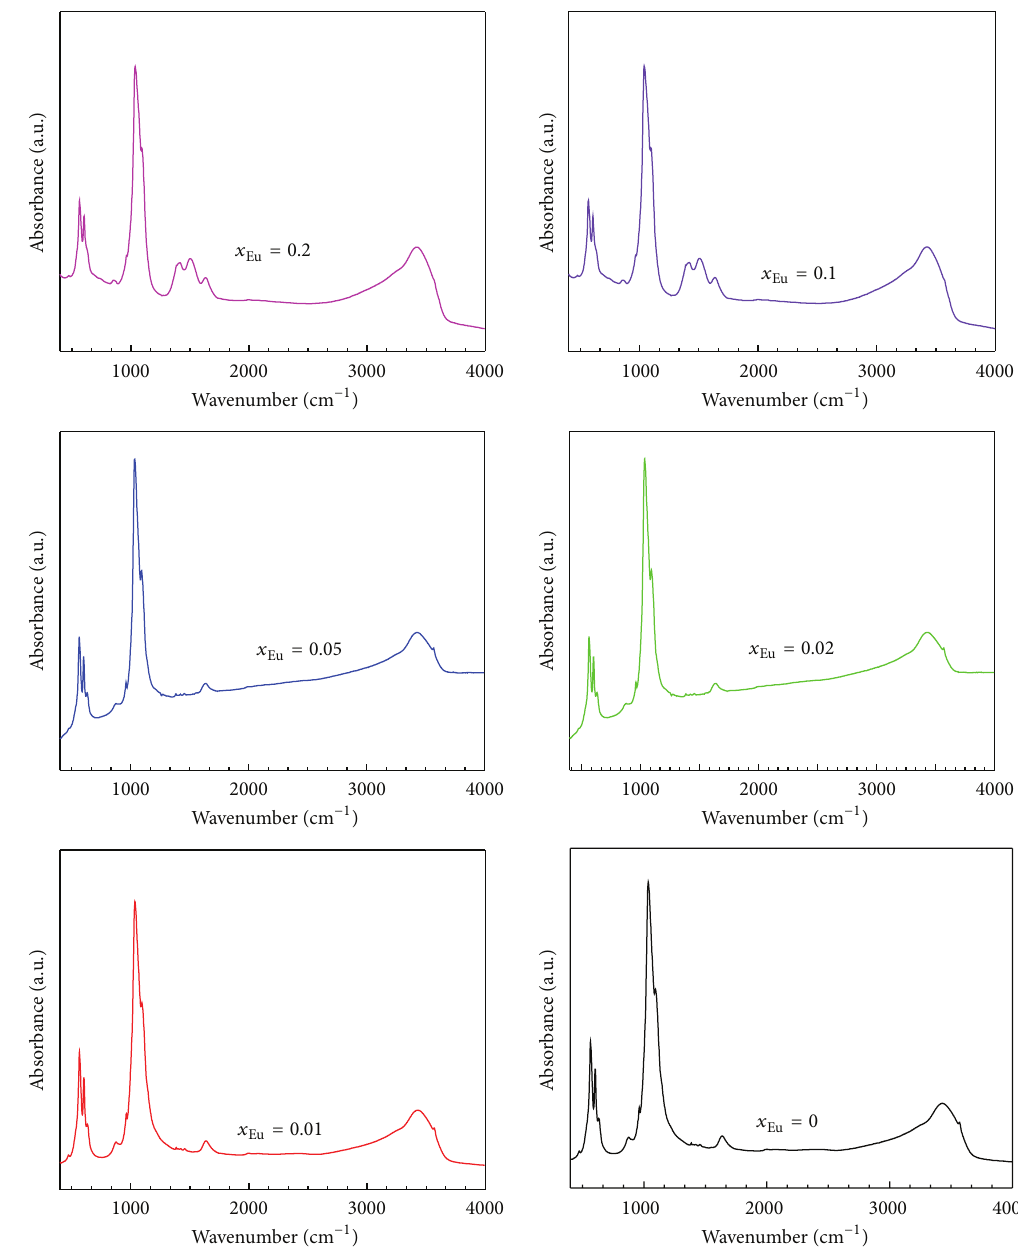
= 0 , 𝑥 = 0.02 , and 𝑥 = 0.2 . Eu Eu Eu